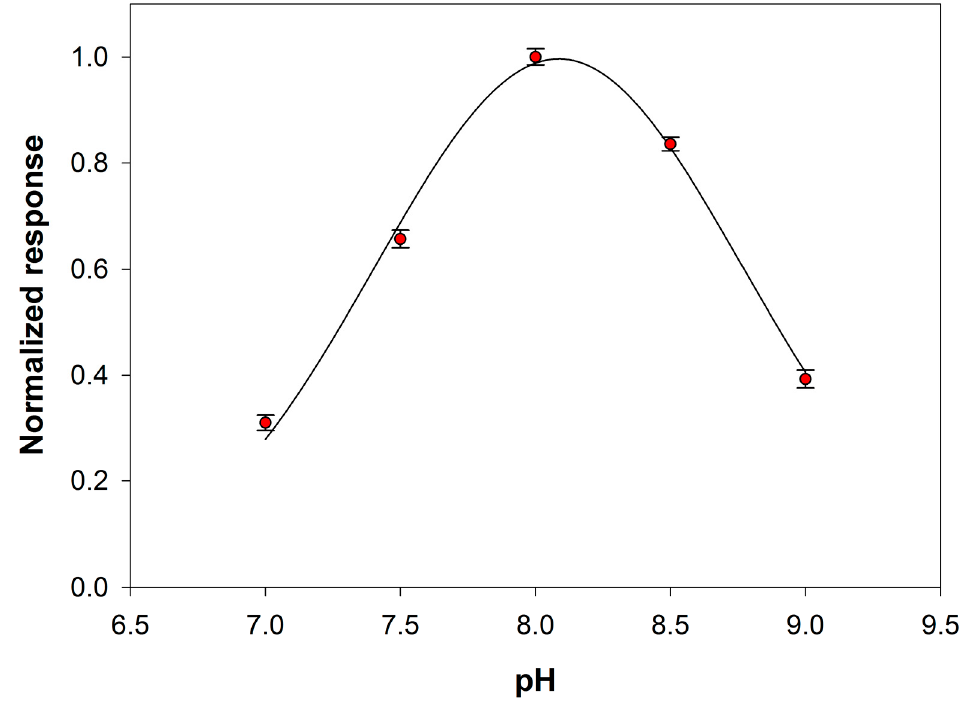
Figure 5. Normalized response (i.e., response/maximum response) of a typical Pt/PPyox/ChO biosensor to PLD 0.22 IU/mL as a function of pH. Supporting electrolyte: borate buffer pH 8.0, I 0.05 M containing 0.75% (v/v) Triton X-100, 0.2 mM calcium chloride, and 5 mM phosphatidylcholine. Electrode rotation rate: 200 rpm.